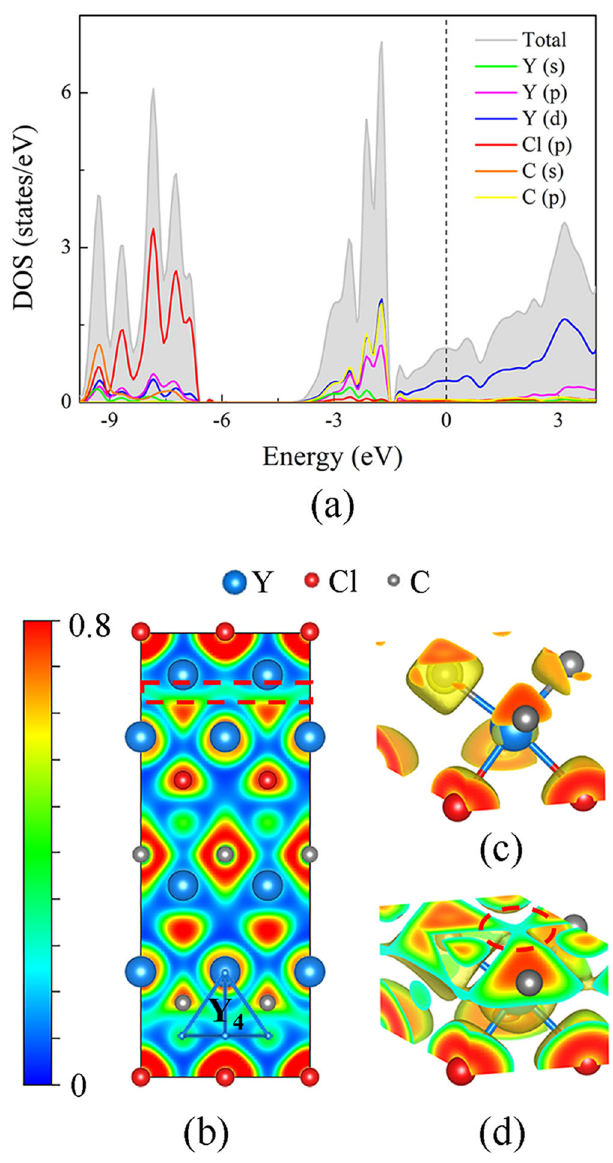
Fig. 4 Results of theoretical calculations. a The total and projected densities of states (TDOS and PDOS) curves of Y 2 ClC at 40 GPa; the Fermi energy level was set to 0 eV. b The 2D electron localization function (ELF) map of Y 2 ClC in the (1 0 0) plane; c , d ELF with the isosurfaces value set as c 0.7 and d 0.25. Y, Cl, and C atoms are shown in blue, red, and gray colors. One Y 4 tetrahedron is highlighted in 4b, and the weak ELF value in its center is highlighted with the red dashed circle in d . These weak ELF values in the centers of the Y 4 tetrahedra form bridges connecting the C atoms (highlighted with the red dashed square in b